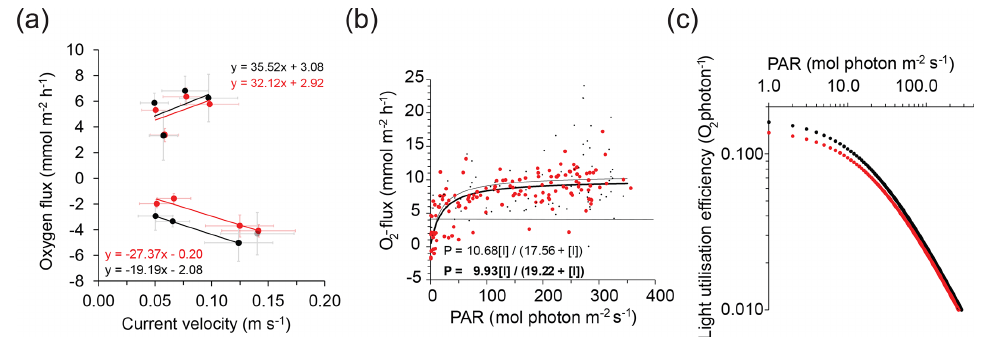
Figure 5. Effect of flow and light on flux. (a) Effect of flow velocity on day- and nighttime fluxes measured with the 3OEC (red circles and line) and 2OEC (black circles and line). The data points indicate the average fluxes calculated for light daytime and dark nighttime periods, separated at 20:00, plotted against the average flow velocity for the respective time periods. Compromised data point from the 16 July 2OEC deployment was excluded from regression (grey circle). Error bars represent standard error. (b) Increase in daytime fluxes with increasing light intensity at the seafloor. Black curves depict photosynthesis-irradiance curves (red circles, thick line: 3OEC; black dots, thin line: 2OEC) calculated using Michaelis–Menten kinetics ( P = P max [ I ] /(K I +[ I ] ), with P being the photosynthetic rate at a given light intensity, P max the maximum potential photosynthetic rate, [ I ] the light intensity, and K I the half-saturation constant, i.e. the light intensity at which the photosynthetic rate proceeds at 1 / 2 P max ). The horizontal black line indicates approximate level of daytime respiration. (c) Light utilisation efficiency of the benthic community based on data shown in (b) (red circles: 3OEC; black circles: 2OEC).